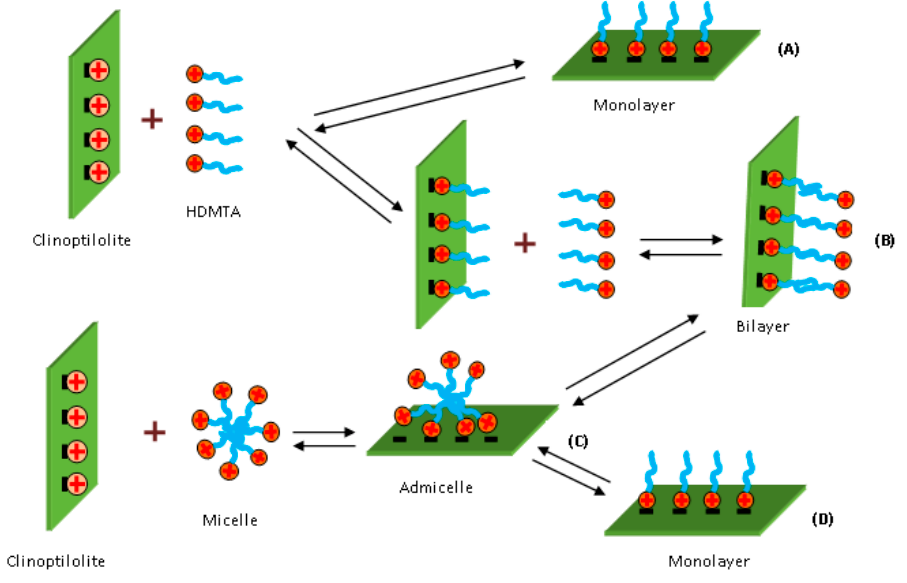
Figure 2. Conceptual model of hexadecyltrimethylammonium ion (HDMTA) adsorption onto natural clinoptilolite. (A) C in,HDTMA < CMC and ISI < ECEC; (B) C in,HDTMA < CMC and ISI > ECEC or C in,HDTMA > CMC and ECEC < ISI < 2ECEC; (C) C in,HDTMA > CMC and ISI > 2ECEC; (D) C in,HDTMA > CMC and ISI < ECEC.